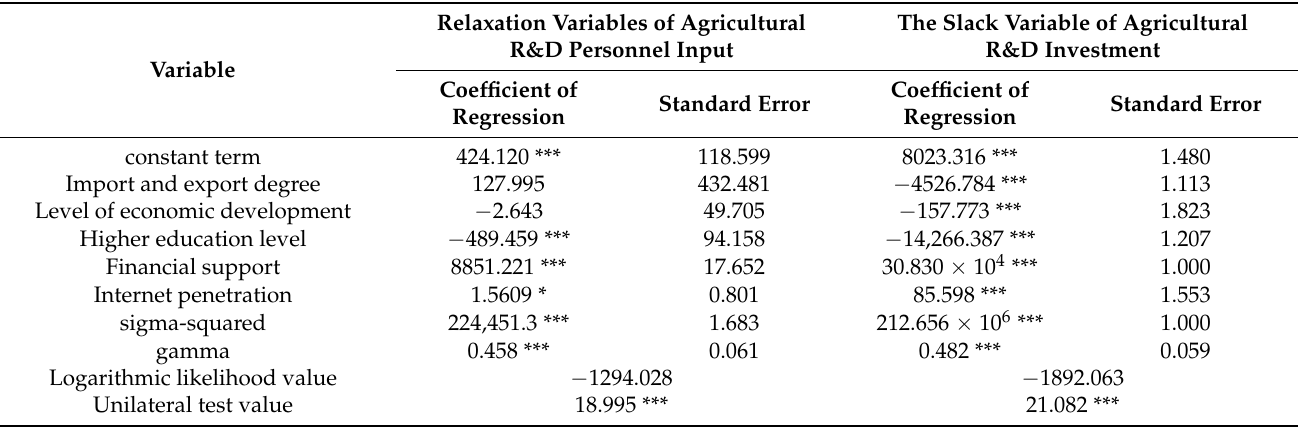
Table 5. Regression results of SFA in the second